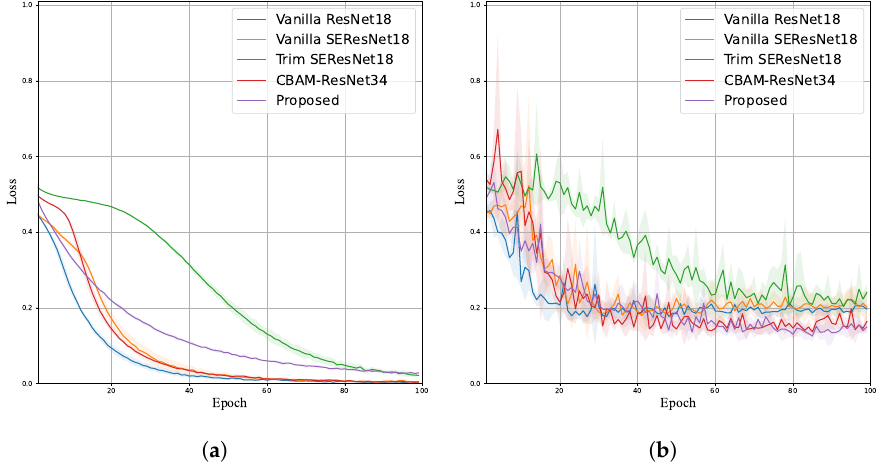
Figure 9. ( a ) Training and ( b ) Validation loss curves of the P-ADSD